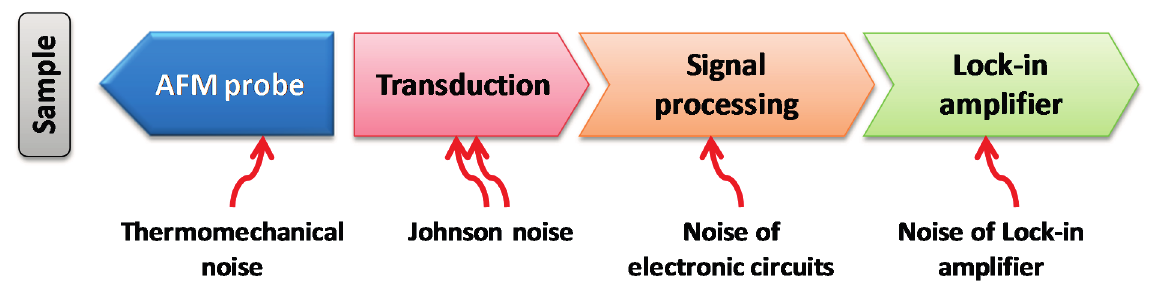
Figure 17. Noise sources identified for the current AFM imaging system.